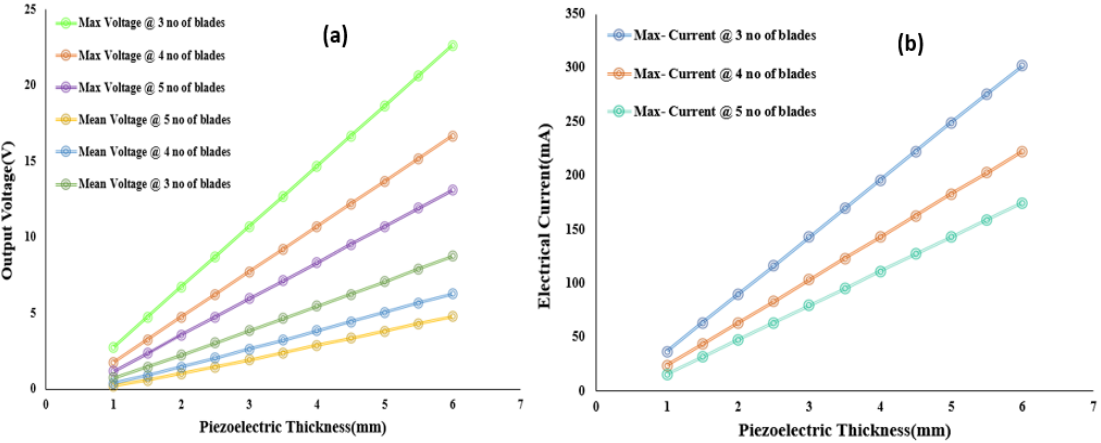
Figure 11. Measurement of output response of harvester via PZT thickness. ( a ) Output voltage, ( b ) Output current.